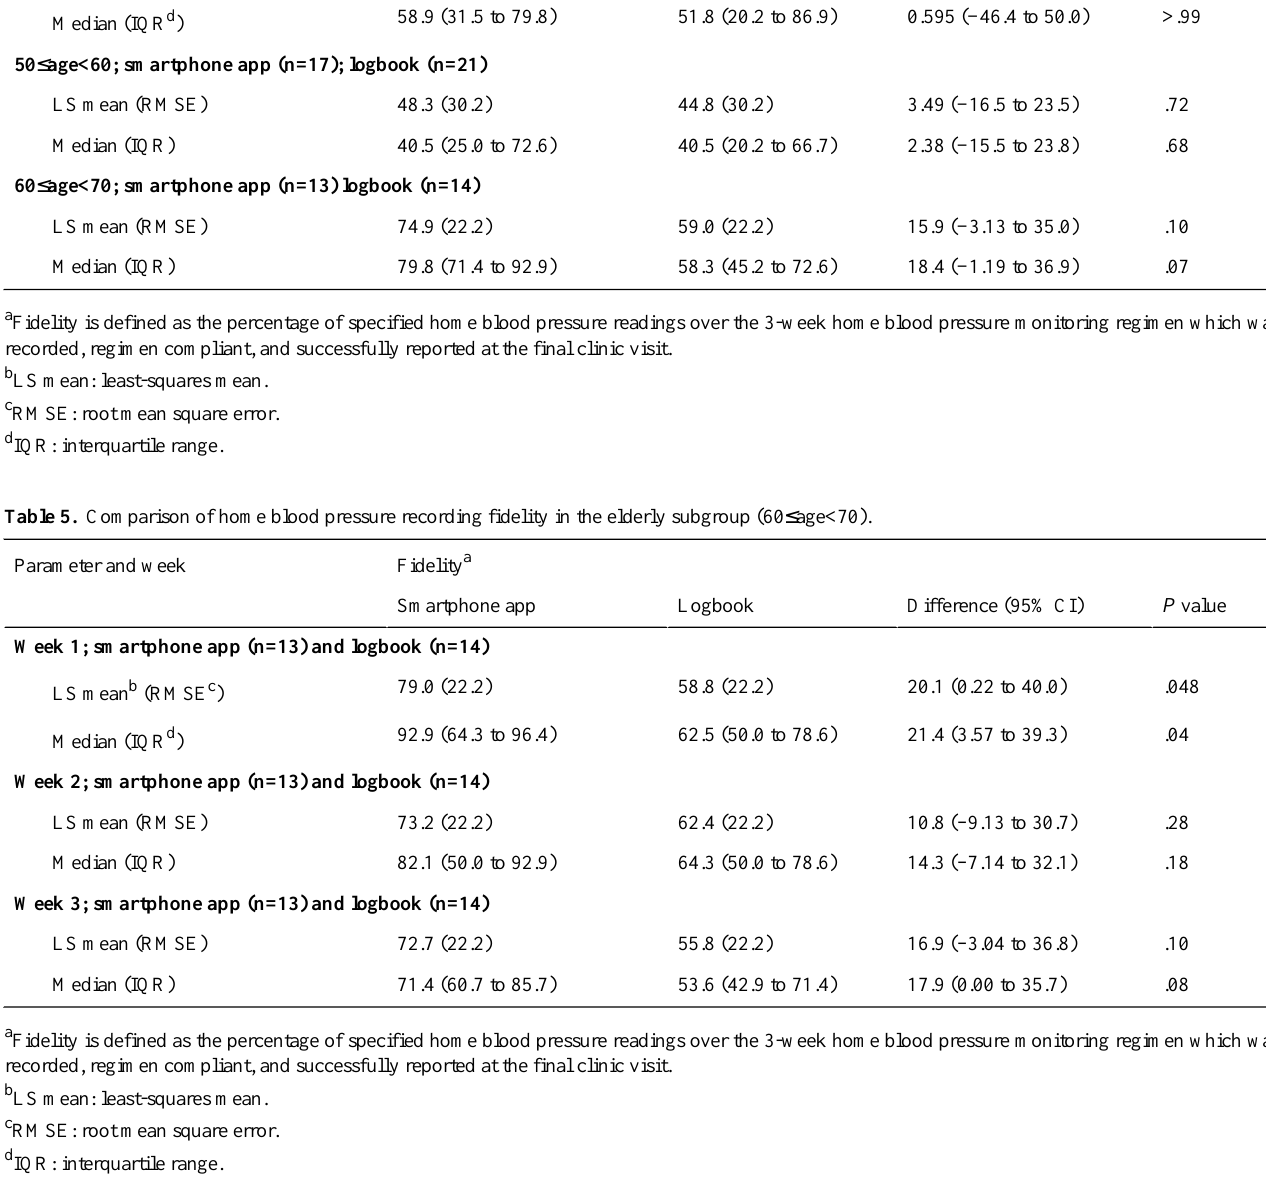
Table 4. Comparison of home blood pressure recording fidelity by age. 40<age<50; smartphone app (n=8); logbook (n=6)